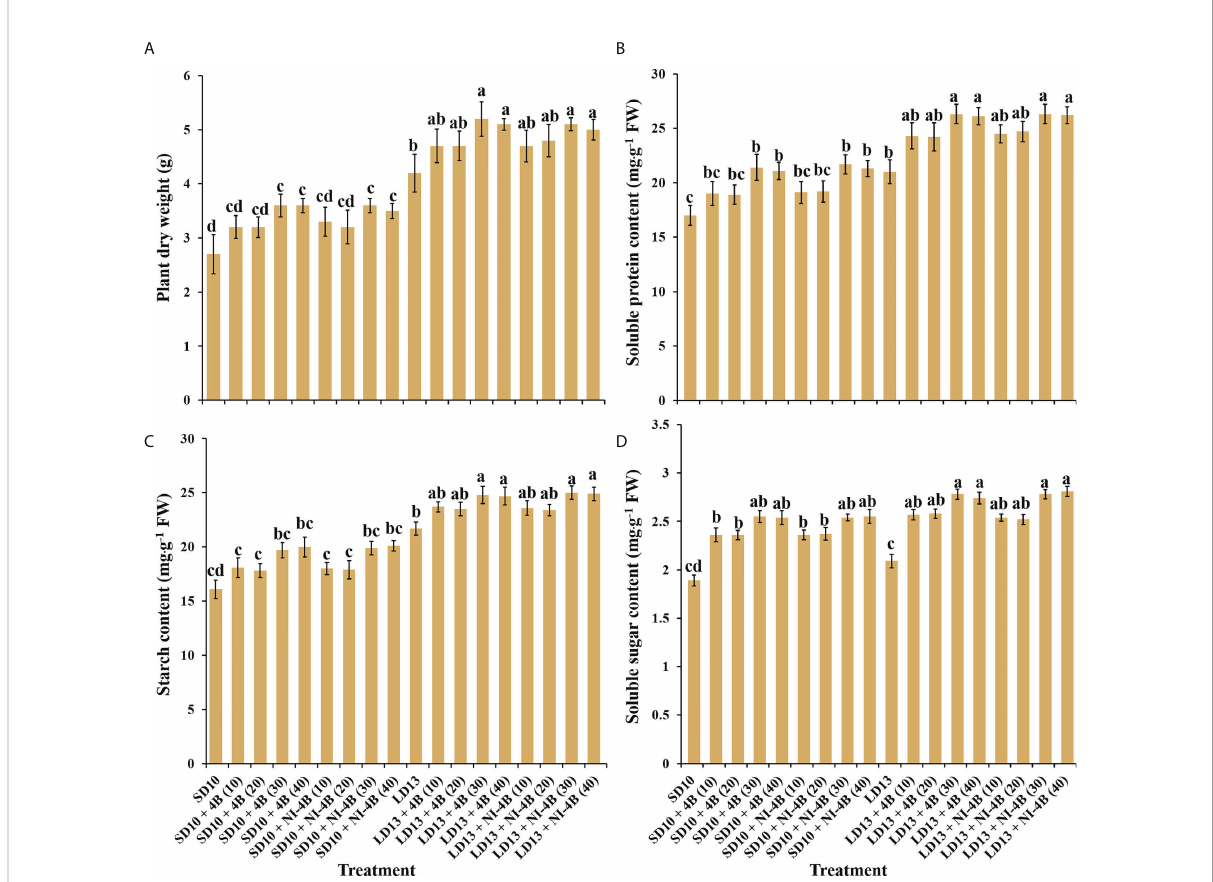
FIGURE 5 The effects on the plant dry weight (A) , soluble protein (B) , starch (C) , and soluble sugar (D) contents of chrysanthemum ‘ Gaya Glory ’ under different intensities of supplemental or night-interruptional blue light, after 60 days of exposure to the photoperiodic light treatments. Vertical bars indicate the means ± standard error (n = 6). Different lowercase letters indicate signi fi cant separation within treatments by Duncan ’ s multiple range test at p ≤ 0.05. See Figure 1 for details of photoperiodic light treatments with blue